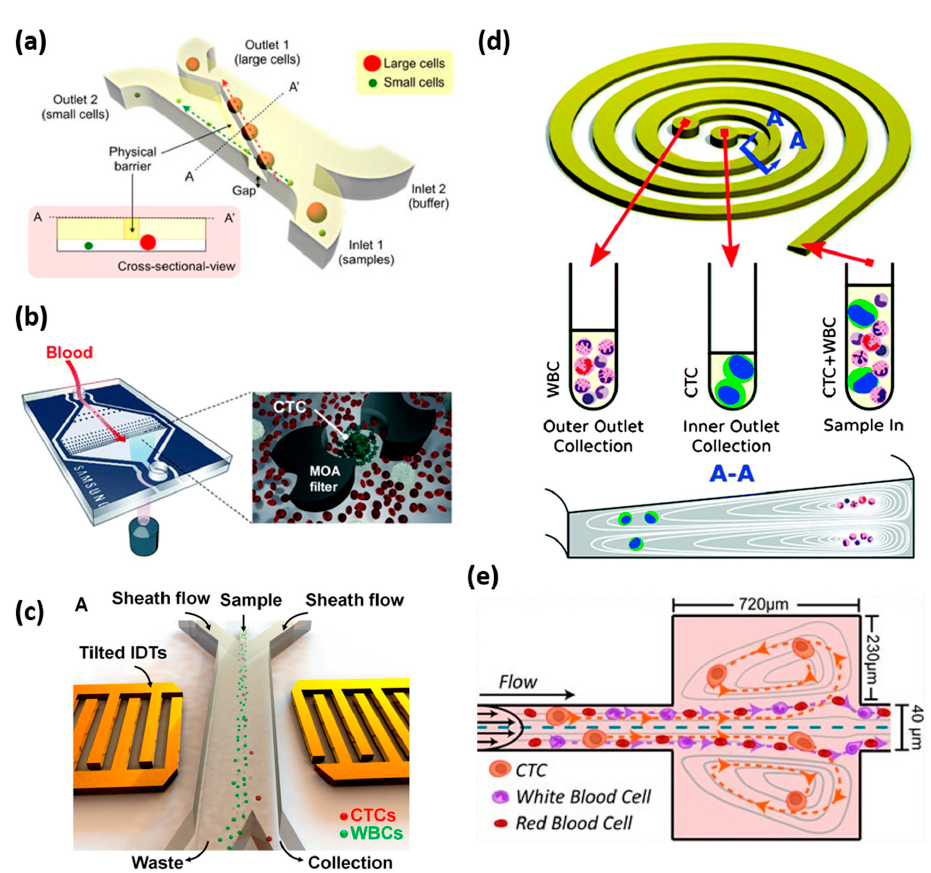
Figure 3. Label-free CTC isolation method. ( a ) Illustration of microfluidic cell sorter. A physical barrier is located, as shown, to separate the cells by size difference. Small cells pass through the gap under the barrier and are collected at outlet 2, while the large cancer cells move along the barrier and are collected at another outlet. Reprinted with permission from the authors of [83]; ( b ) Schematic of the multi-obstacle architecture microfiltration chip for CTC separation. The size gradient filter chip has two filter gaps and the cells are captured between the two filter gaps. Reprinted with permission from the authors of [82]; ( c ) Schematic of acoustic tweezers for isolating circulating tumor cells from a blood sample. These yellow tilted transducers generate soundwaves to move the cells as they pass through the device. The tumor cells are separated from the blood cells based on the difference in size and compressibility. Reprinted with permission from the authors of [91]; ( d ) The principle of CTC enrichment by a spiral channel. The CTCs are focused near the inner wall because of the combination of the inertial lift force and the Dean force, while the white blood cells are focused closer to the outer wall. Reprinted with permission from the authors of [94]; ( e ) Illustration of VTX-1 CTC isolation platform. A blood sample flows through the microchannels and the laminar microscale vortices trap the cells based on their size, shape, and deformability. Reprinted with permission from the authors of [95].